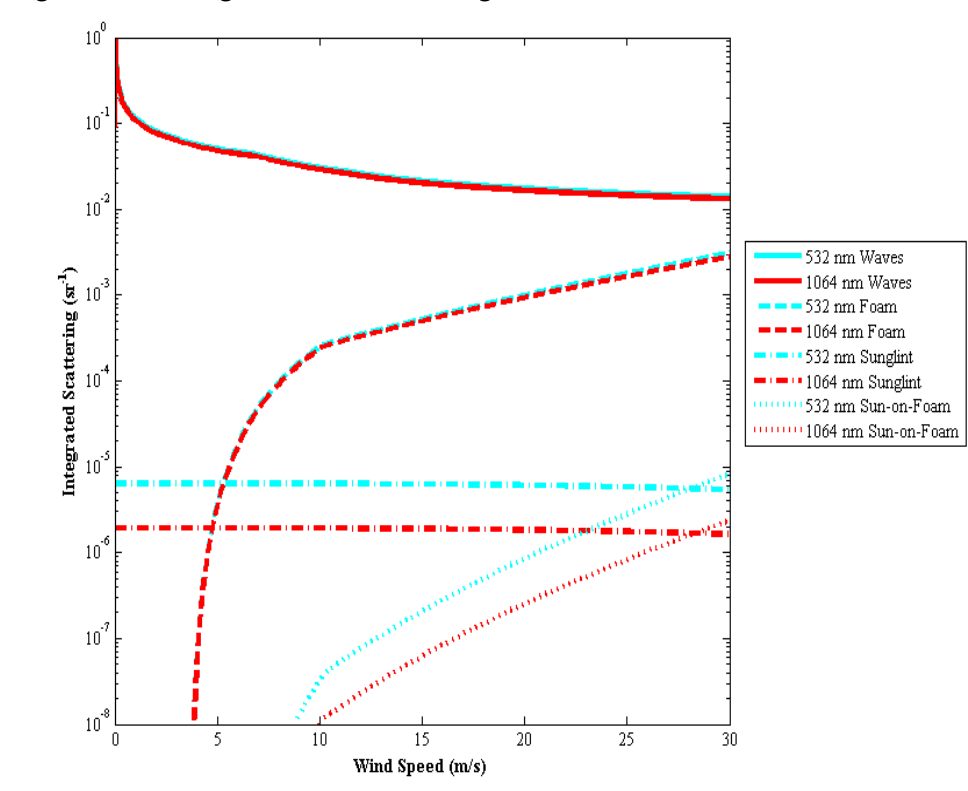
Figure 3. Theoretical CALIOP scattering off water surface as a function of wind speed for 532 and 1064 nm wavelengths. Wave scattering is modeled using Equation (2). Foam scattering and sun-on-foam are modeled by Equation (10). Sun glint is modeled as Equation (11). Graphs illustrate the relative importance of the different components to the total integrated scattering. The solar zenith angle is assumed to be